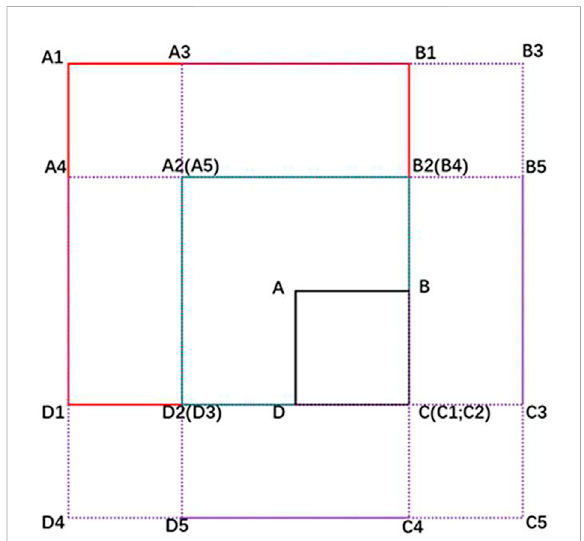
FIGURE 3 Schematic diagram of the 16th – 20th similarity region (P2). C is the TC position at the initial time and A is the TC position at the maximum lead time, with ABCD denoting the fi rst value of P2. The 16th value is a square (A1B1C1D1) with C as the southeastern vertexandasidelengthof2000 km.B2isthemidpointofBandB1, while D2isthemidpointofDand D1,andA2B2C2D2 isamedium- sized rectangle as the 17th value of P2. Shifting A1B1C1D1 to the right by the distance of D1D2, down by the distance of B1B2, right by the distance of D1D2, and down by the distance of B1B2, simultaneously, produces A3B3C3D3, A4B4C4D4, and A5B5C5D5 as the 18th – 20th values of P2, respectively.